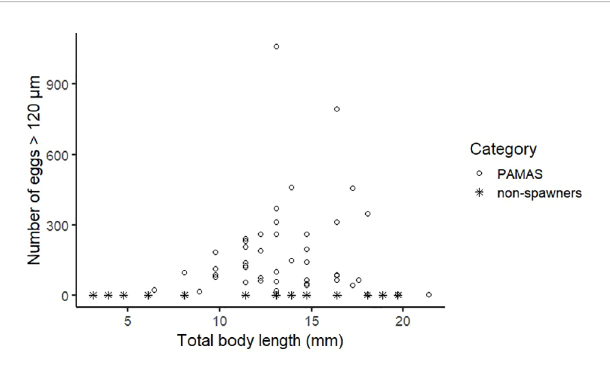
FIGURE 5 Size distribution of mature eggs (mean ± SD) collected during natural spawning events from the large polychaetes (N = 3 chambers, n = 20 polychaetes per chamber). ” Mature ” eggs de fi ned by microscopy (Figure